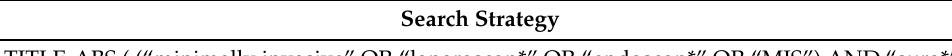
Table 2. Search strategy.